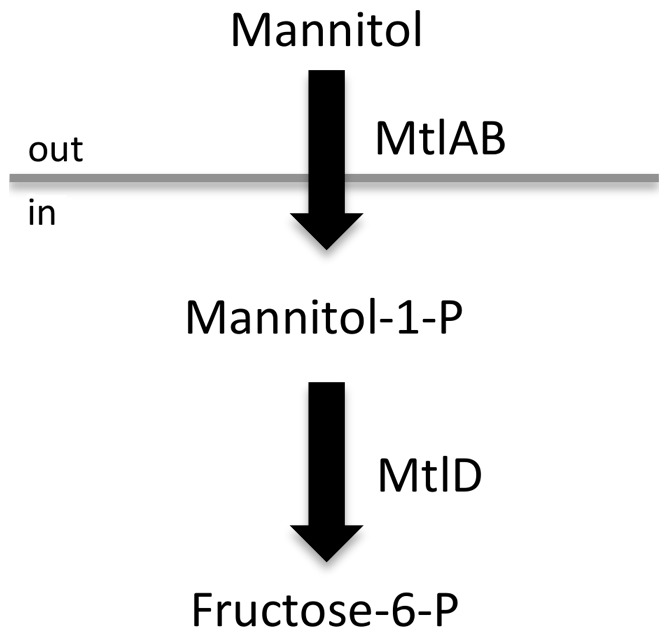
Mannitol uptake pathway in S. aureus.The mtlABFD operon encodes the Mtl-specific PTS (MtlAB) and the operon transcriptional repressor (MtlF); Mtl-1-P 5-dehydrogenase, encoded by mtlD, catalyses the conversion of Mtl-1-P to fructose-6-P which enters into the Embden-Meyerhoff and hexosemonophosphate glycolytic pathways.